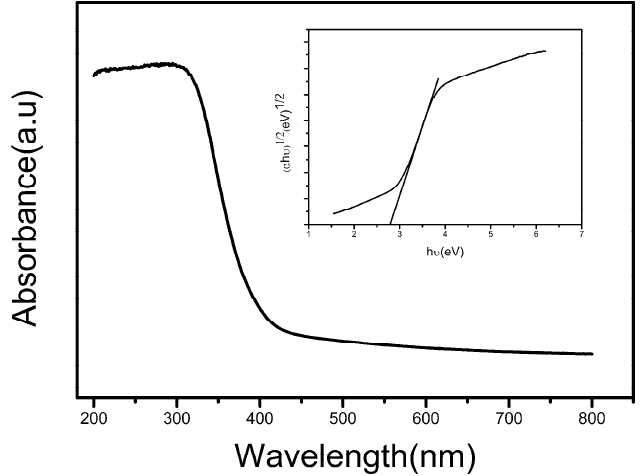
Figure 4. Ultraviolet (UV) ‐ vis diffuse reflectance spectra of hierarchical Bi 2 WO 6 hollow microspheres. The insert is the corresponding ( α hv ) 1/2 versus photon energy plots. The sample was fabricated at 160 °C for 12 h.